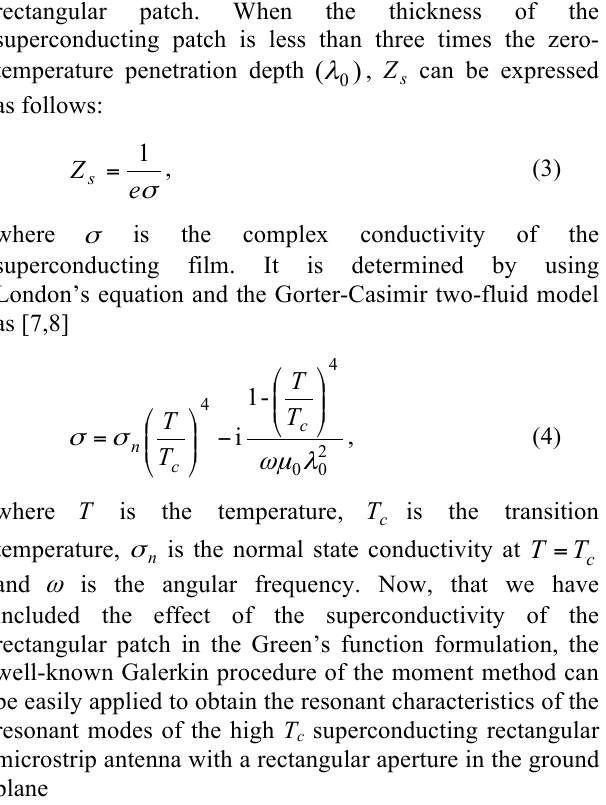
Figure 1: Geometrical structure of a high T the ground